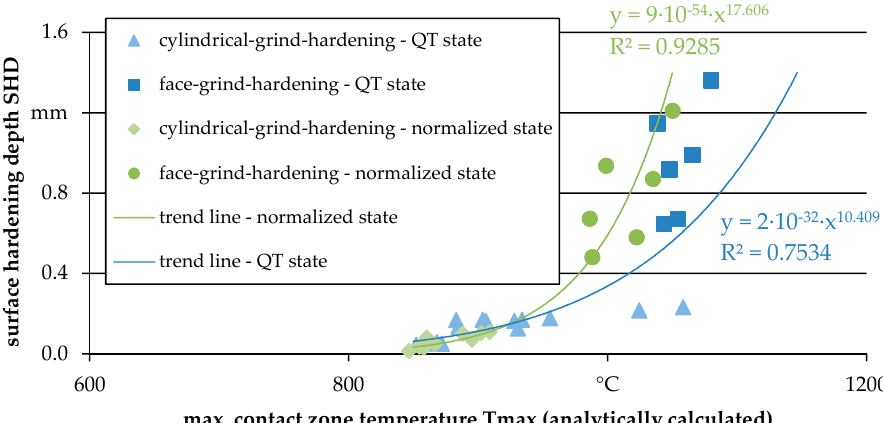
Figure 5. The surface hardening depth (SHD) due to the maximum contact zone temperature T max .